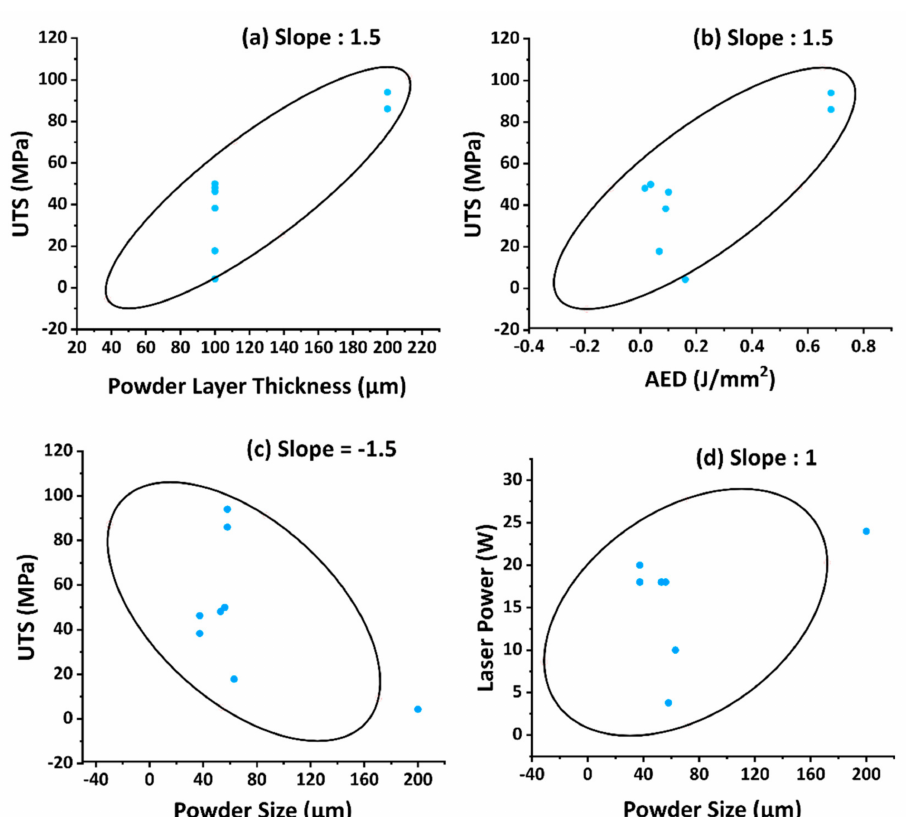
Figure 14. Scatter plots for ( a ) powder layer thickness vs. UTS, ( b ) AED vs. UTS, ( c ) powder size vs. UTS, and ( d ) powder size vs. laser power according to Table 1. A 68% confidence ellipse is depicted for each